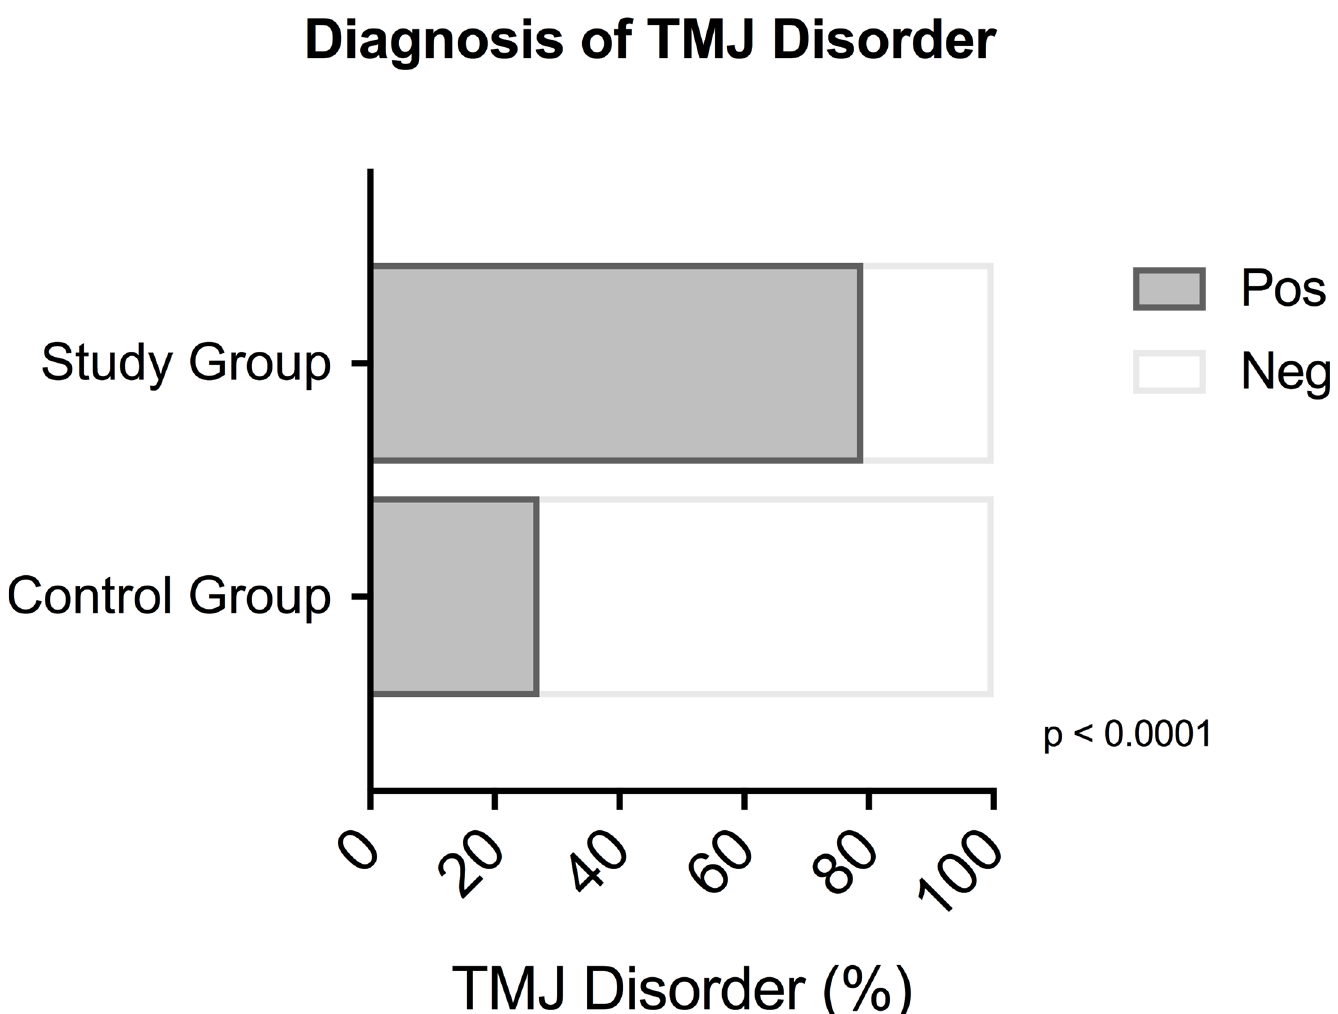
Fig 2. Diagnosis of temporomandibular joint (TMJ) disorders. Diagnosis of TMJ disorders according to Diagnostic Criteria for Temporomandibular Disorders (DC/TMD) Axis I in patients in the study and control groups. A significantly higher number of TMJ disorders was found in patients in the study group compared to the control group (p <